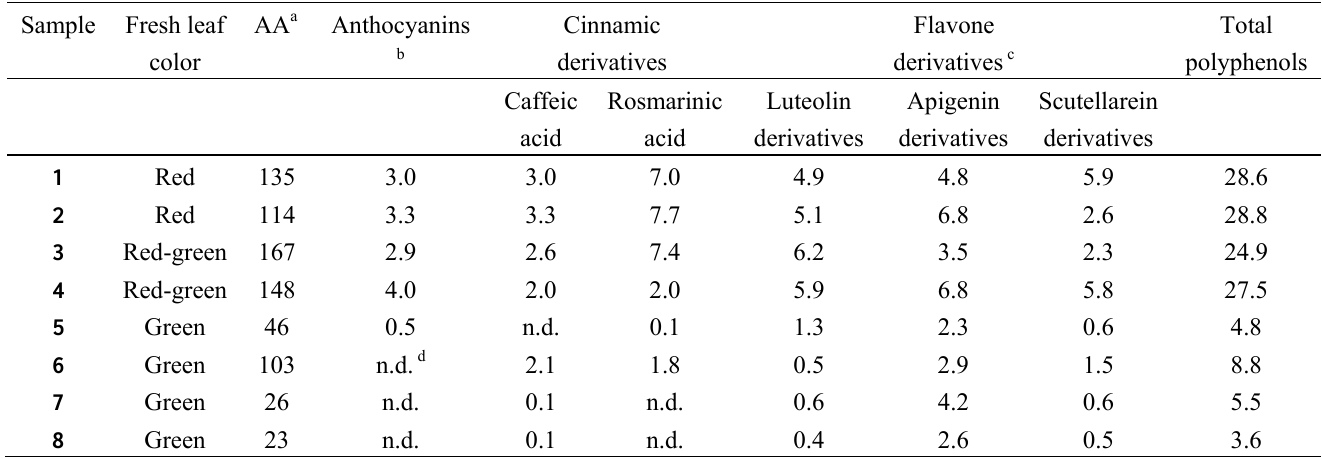
Table 1. Antioxidant Activity (µmol TE/100 mL) and Polyphenol contents (µmol/100 mL) in Perilla frutescens water